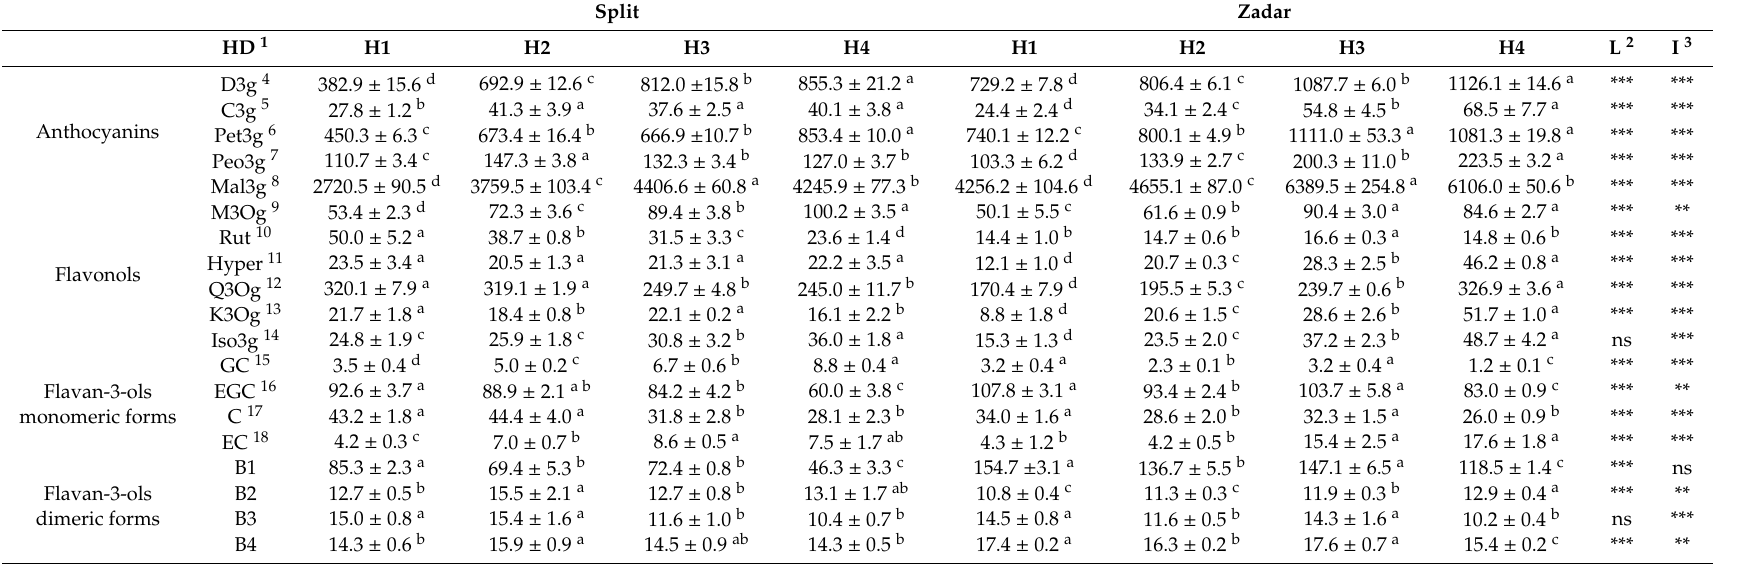
Table 2. Flavonoid composition (mg kg − 1 dry weight) of Plavac Mali grape skin at four di ff erent harvest dates at two